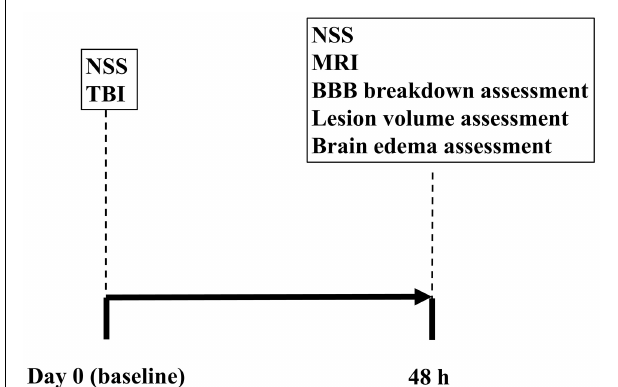
FIGURE 1 | Experimental